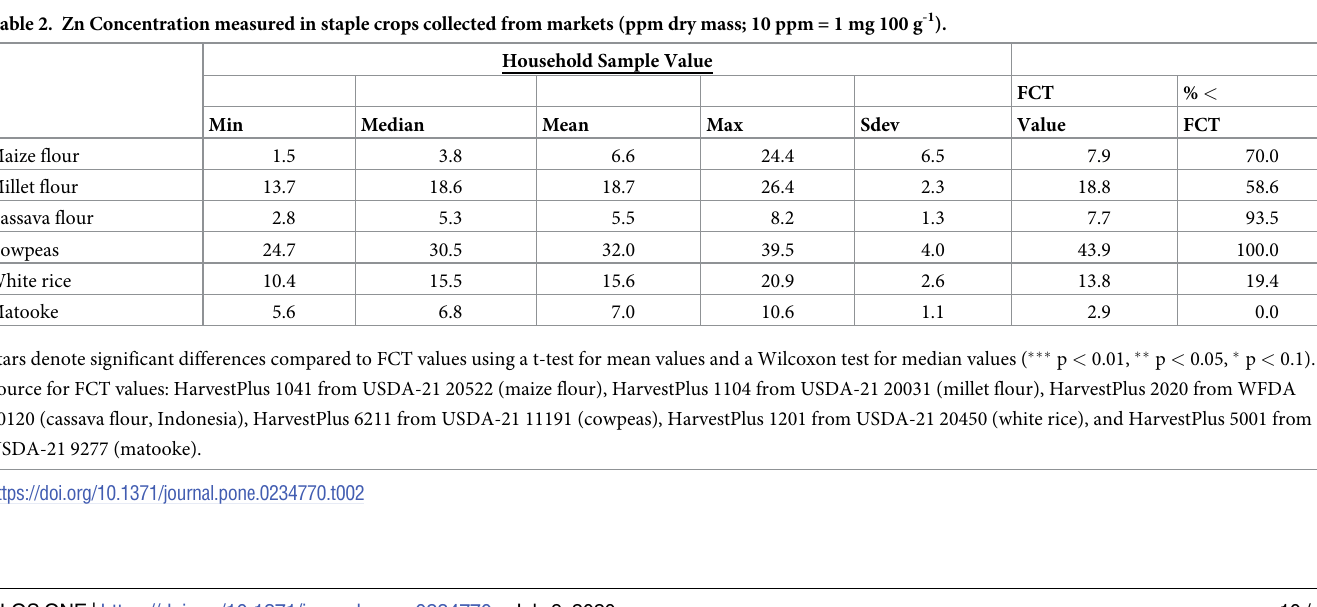
mean value of 5.6 ppm and a median value of 4.8 ppm.) However, due to the skewed distribu- tion of the Zn concentrations (Fig 4), the median value provides a better representation of the “typical” maize flour found at market than the mean, and that sample median value is almost half of the sample average value (Table 2). The median Zn concentration of matooke samples collected from markets was more than twofold higher than the value reported in the Harvest- Plus FCT (Table 2). However, the median Zn concentrations of maize flour, cassava flour, and cowpea samples collected from markets were approximately 50%, 70%, and 66% lower than the values reported in the FCT, respectively (Table 2 and Fig 4). The median Zn concentrations